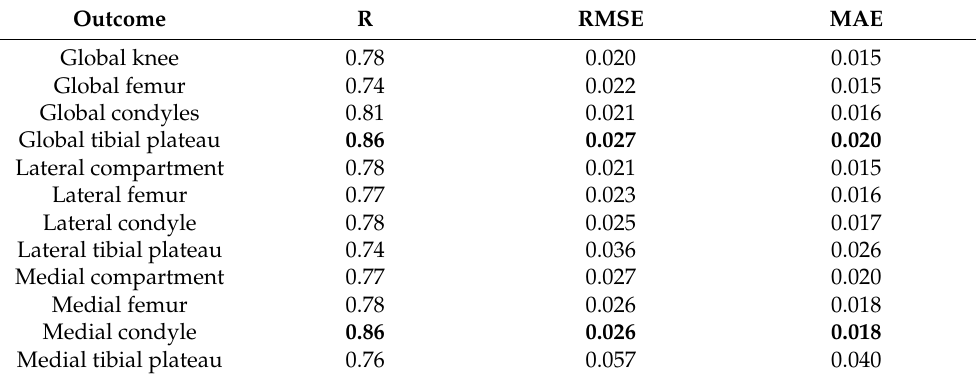
Table 2. Performance of prediction of cartilage volume loss at one year in 12 regions using the ANFIS